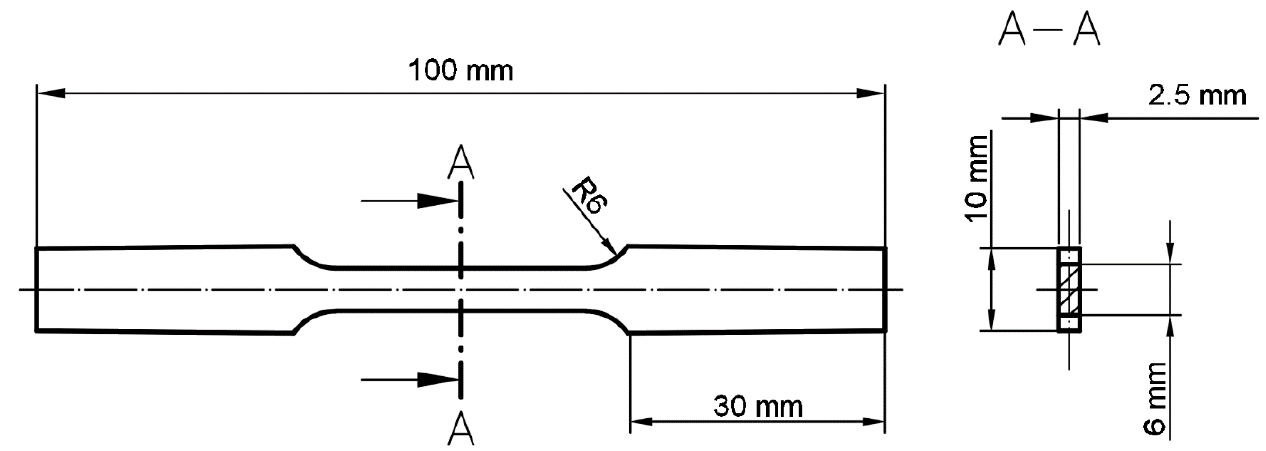
Figure 2. Dimensions of the ASTM E8\E8M standard tensile test dog-bone